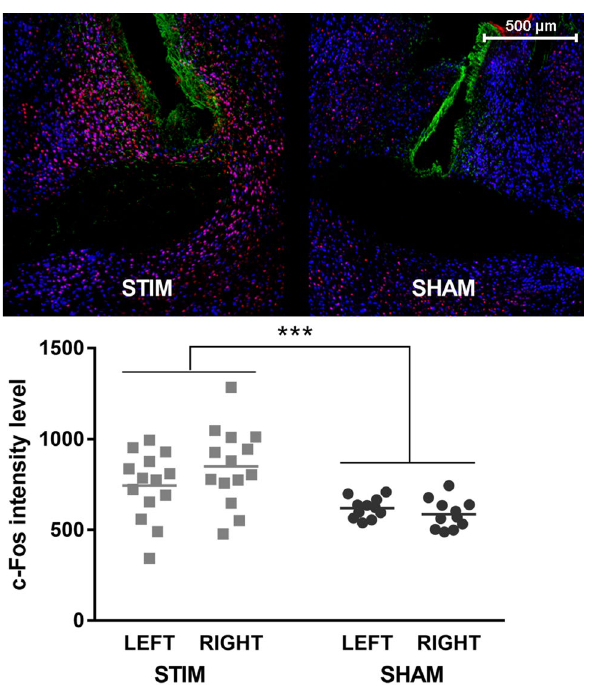
Figure 7. Neuronal c-Fos expression around the electrode tips. Representative images of immunostained cross- sections at the level of the electrode tips in a STIM (left upper panel) and a SHAM animal (right upper panel). Green staining represents GFAP and gliosis surrounding the electrode tip, blue cells are neurons (NeuN), and c-Fos expression is depicted in red. The bottom panel shows average neuronal c-Fos intensity in a 500-µm radius around the electrode tip for all STIM (n = 14, squares) and SHAM (n = 11, circles) animals. Individual data and means are shown, ***p <